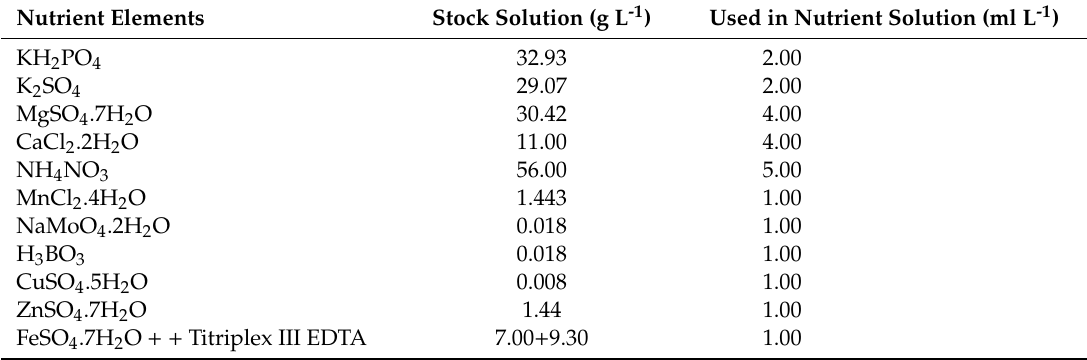
Table 1. The composition of the nutrient solution used in the experiment (pH 6.5). Nutrient Elements Stock Solution (g L -1 ) Used in Nutrient Solution (ml L -1